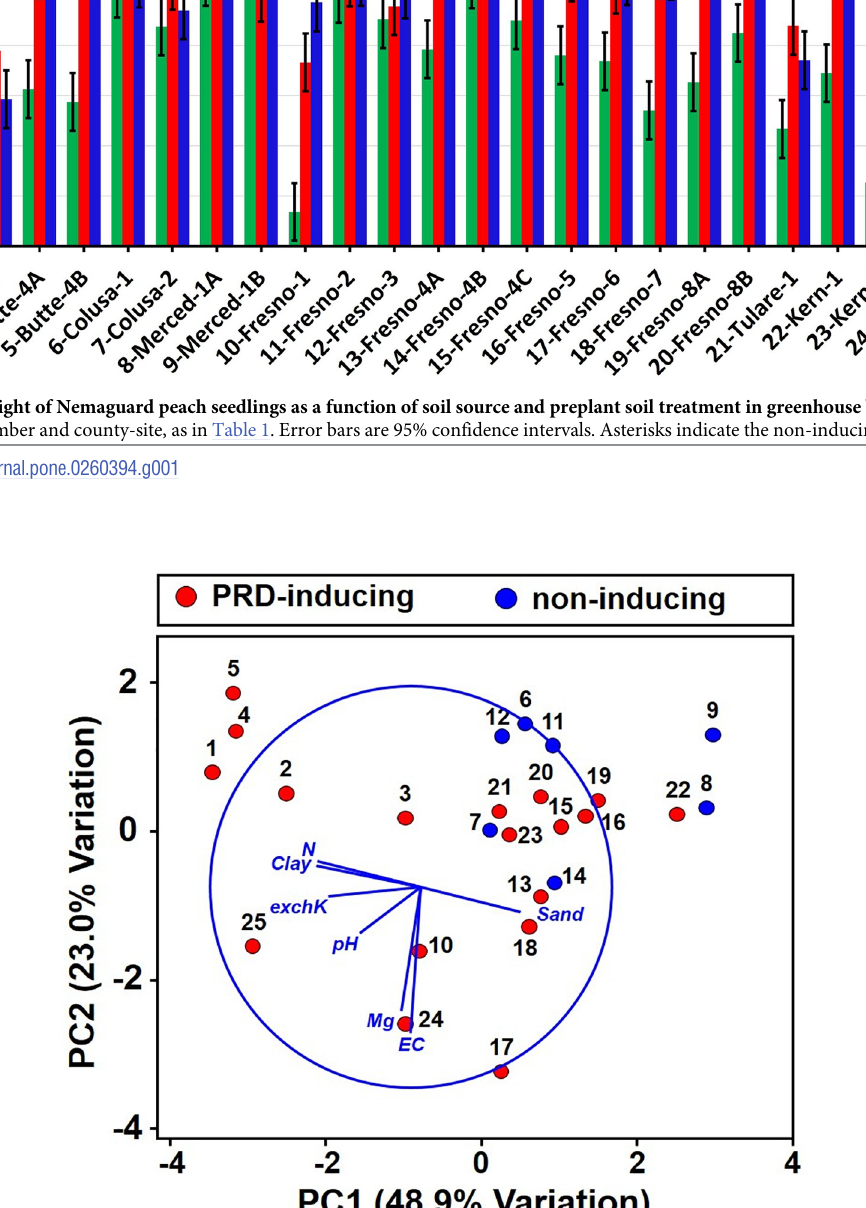
PLOS ONE | https://doi.org/10.1371/journal.pone.0260394 December10,